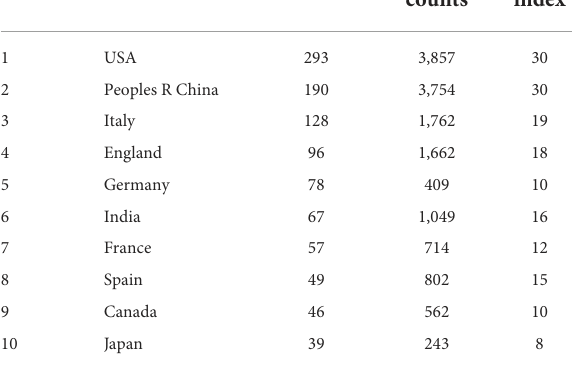
TABLE 3 Top 10 prolific